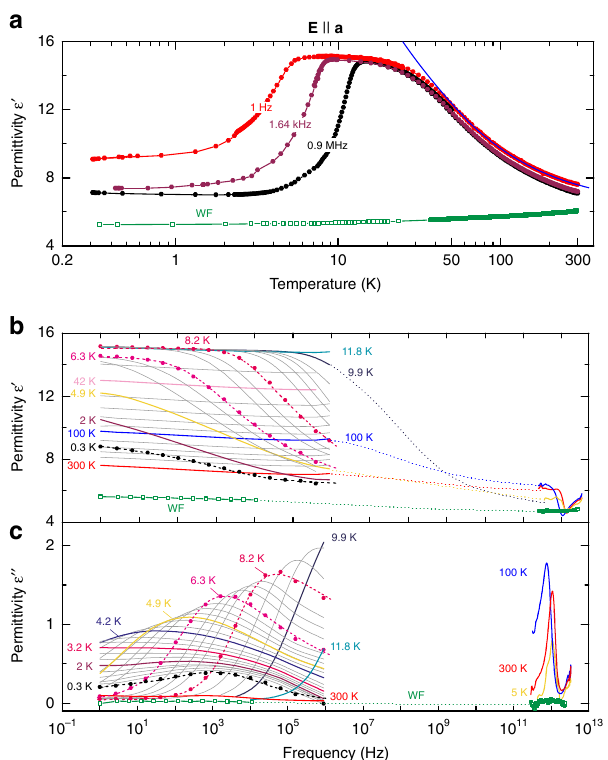
Fig. 2 Temperature evolution of relaxational absorption band. a Temperature dependences of the real part of the dielectric permittivity ε ′ of a hydrous cordierite crystal for E || a polarization at different frequencies as indicated. In addition, ε ′ ( T ) data for a water-free cordierite crystal (WF, 1.2 kHz) are included. The blue solid line shows the result of a least-square fi t with the Curie-Weiss expression, Eq. (1), with C = 390 K and T K. b , c Hz – MHz and THz spectra of the real b and imaginary c parts of the dielectric permittivity of the hydrous cordierite crystal measured at different temperatures as indicated. The short-dashed lines represent least- square fi ts with Eq. (2) of measured spectra shown by full dots. WF denotes the spectra obtained for a water-free crystal (squares). The dotted lines connecting the radiofrequency and terahertz spectra are guides to the eye.